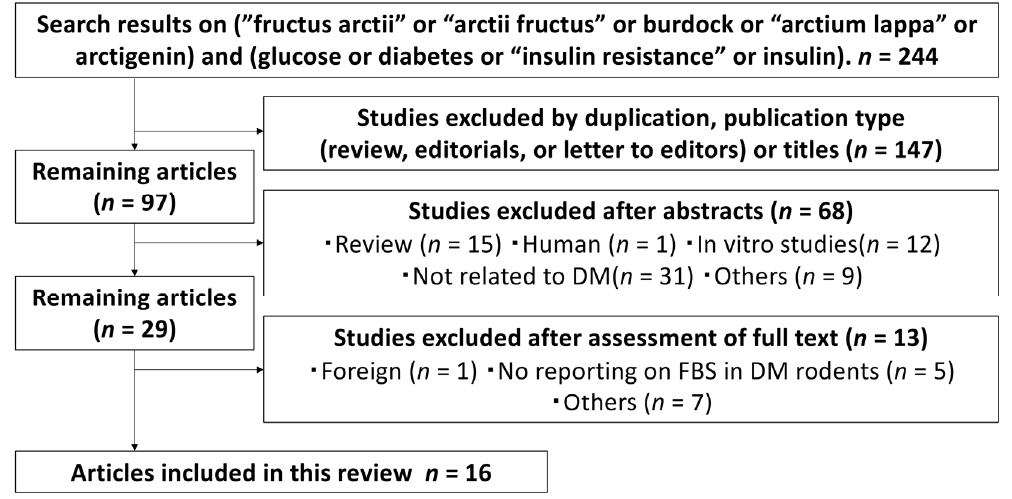
Figure 1. Flowchart of literature search and extraction process.